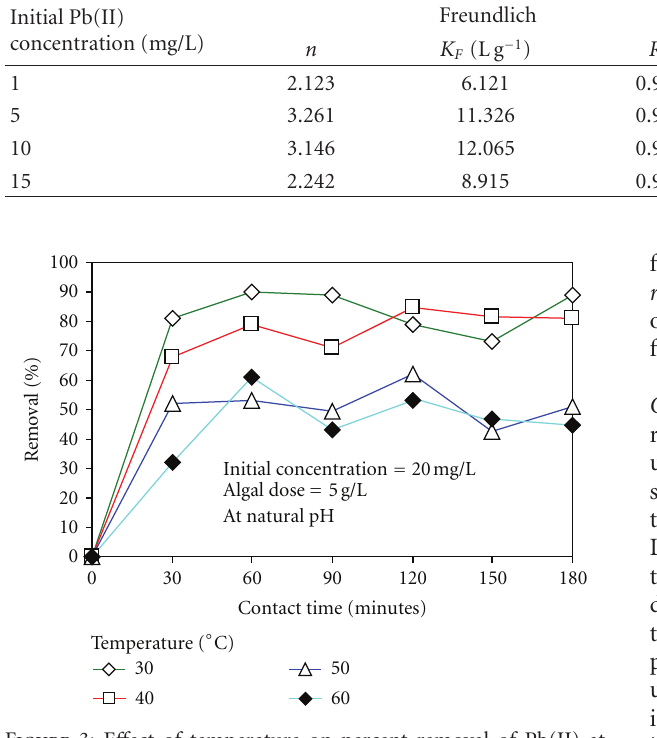
Figure 3: E ff ect of temperature on percent removal of Pb(II) at di ff erent contact time by C. rivularis.